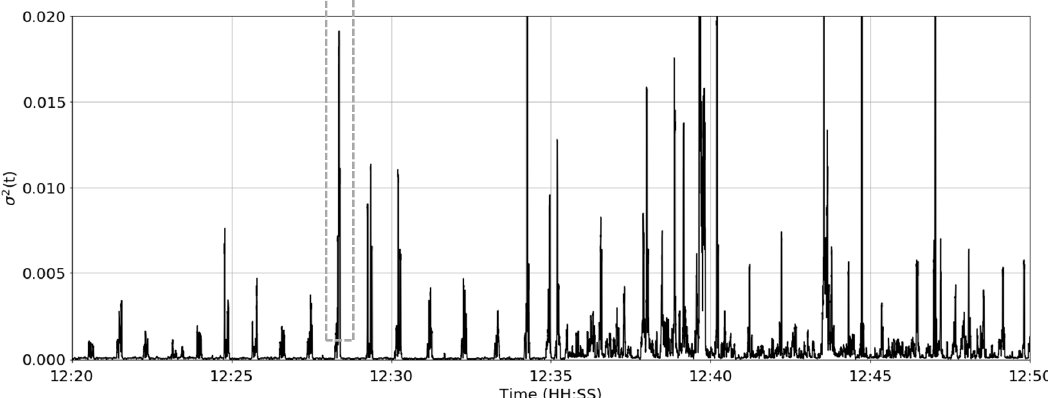
Figure 6. The rolling variance over a 1.5 s window for the same time period in cow #2. The grey dashed line indicates a single apparent rumination contraction with a duration of ≈ 8 s.